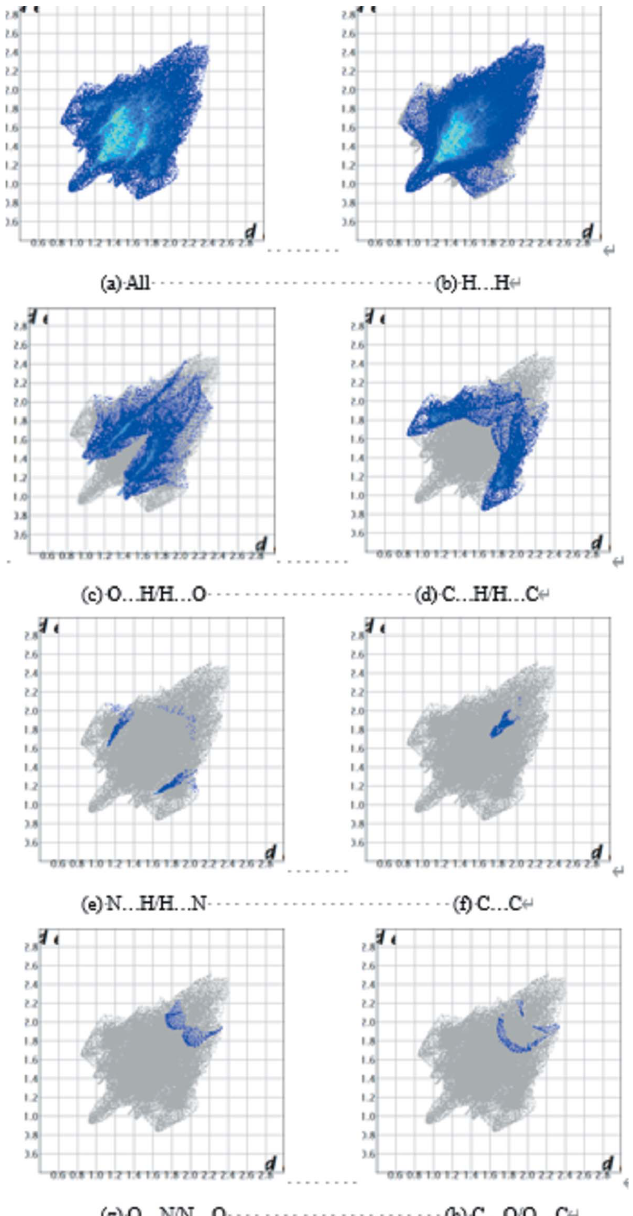
Figure 5 Two-dimensional fingerprint plots for the title compound: ( a ) all intermolecular interactions, ( b ) H (cid:2)(cid:2)(cid:2) H contacts, ( c ) O (cid:2)(cid:2)(cid:2) H/H (cid:2)(cid:2)(cid:2) O contacts, ( d ) C (cid:2)(cid:2)(cid:2) H/H (cid:2)(cid:2)(cid:2) C contacts, ( e ) N (cid:2)(cid:2)(cid:2) H/H (cid:2)(cid:2)(cid:2) N contacts, ( f ) C (cid:2)(cid:2)(cid:2) C contacts, ( g ) O (cid:2)(cid:2)(cid:2) N/N (cid:2)(cid:2)(cid:2) O contacts, ( h ) C (cid:2)(cid:2)(cid:2) O/O (cid:2)(cid:2)(cid:2) C